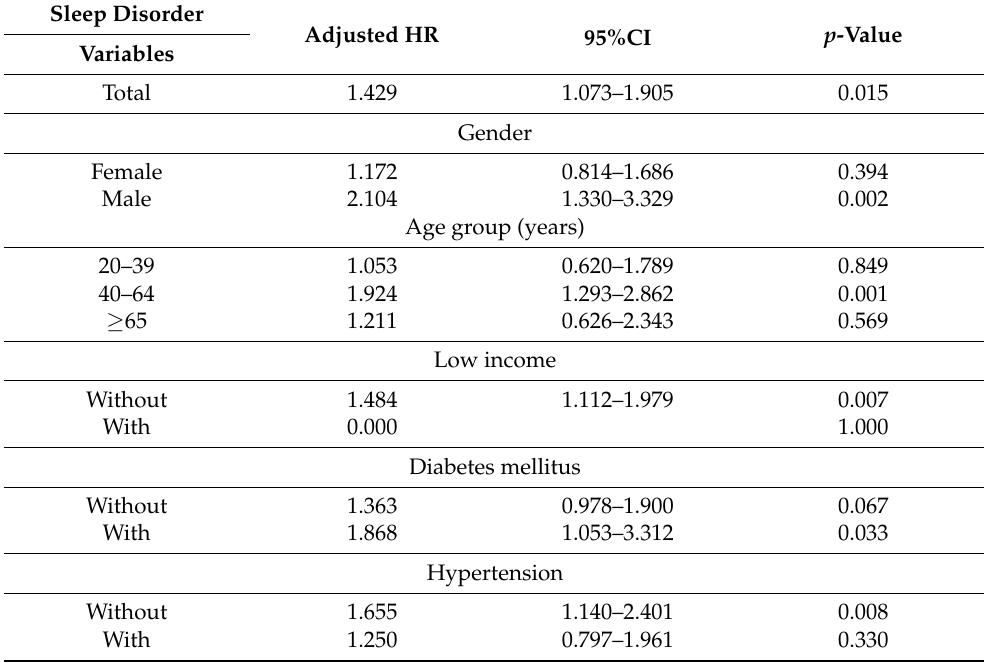
Table 3. Factors related to suicide at the end of the follow-up, stratified by the variables listed in the table using Cox